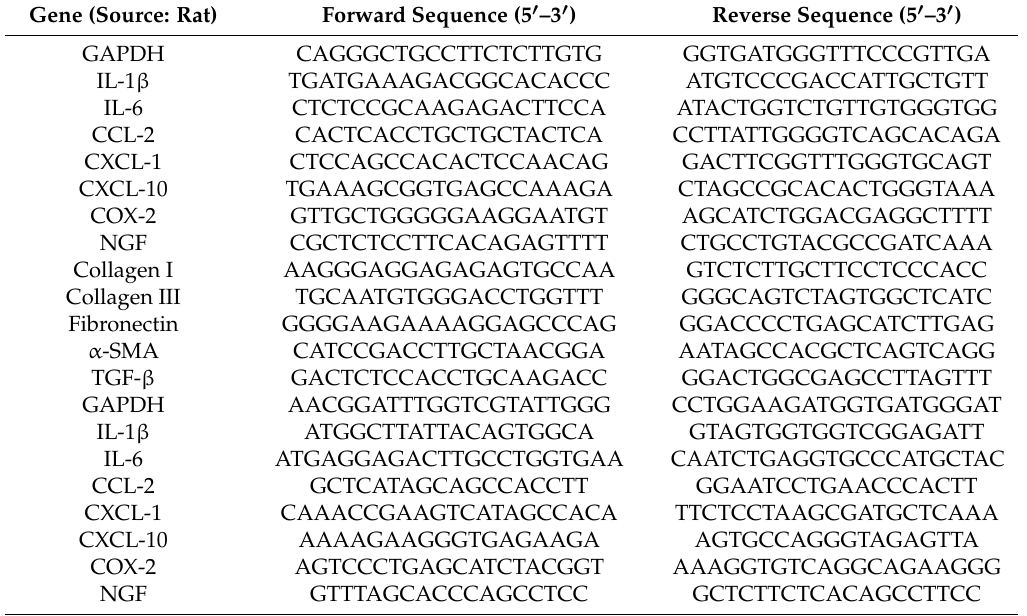
Table 1. Real-time reverse transcription-polymerase chain reaction (RT-PCR) primers. Gene (Source: